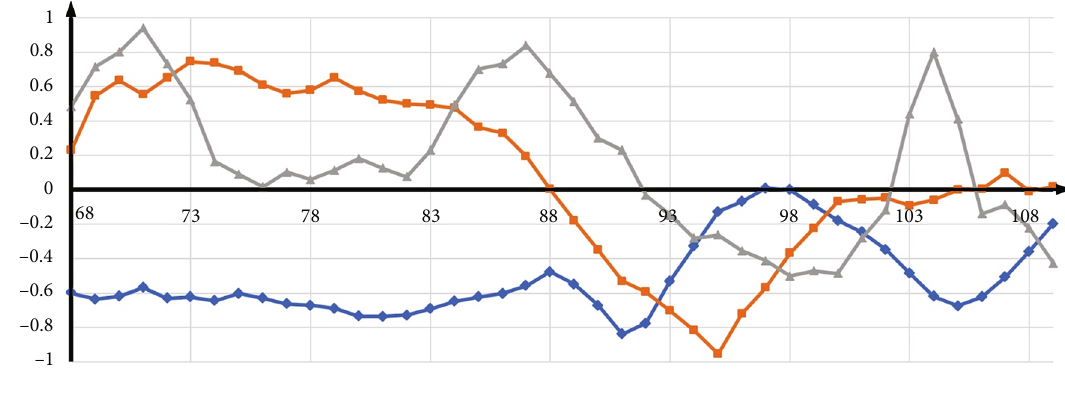
Figure 9: Lode – Nadai coe ffi